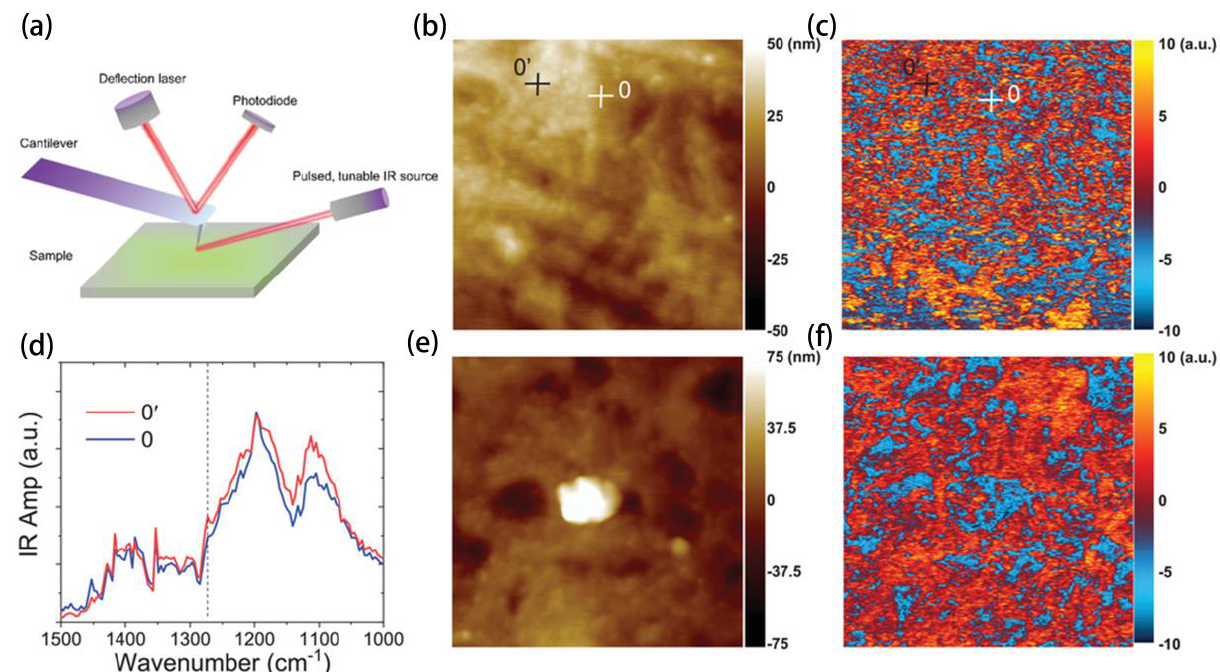
Figure 2. ( a ) Schematic of AFM–IR setup. ( b ) Simultaneously measured topography (2 × 2 µ m 2 ) and ( c ) AFM–IR chemical maps with irradiation by a laser at 1275 cm –1 of P(VDF-TrFE-CFE) terpolymer. ( d ) Local spectra of the sites. ( e ) Simultaneously measured topography (2 × 2 µ m 2 ) and ( f ) AFM–IR chemical maps with irradiation by a laser at 1275 cm –1 in the BTO/P(VDF-TrFE-CFE) nanocomposites with BTO of 400 nm in diameter. Reproduced from [98] with permission from the John Wiley and Sons, copyright